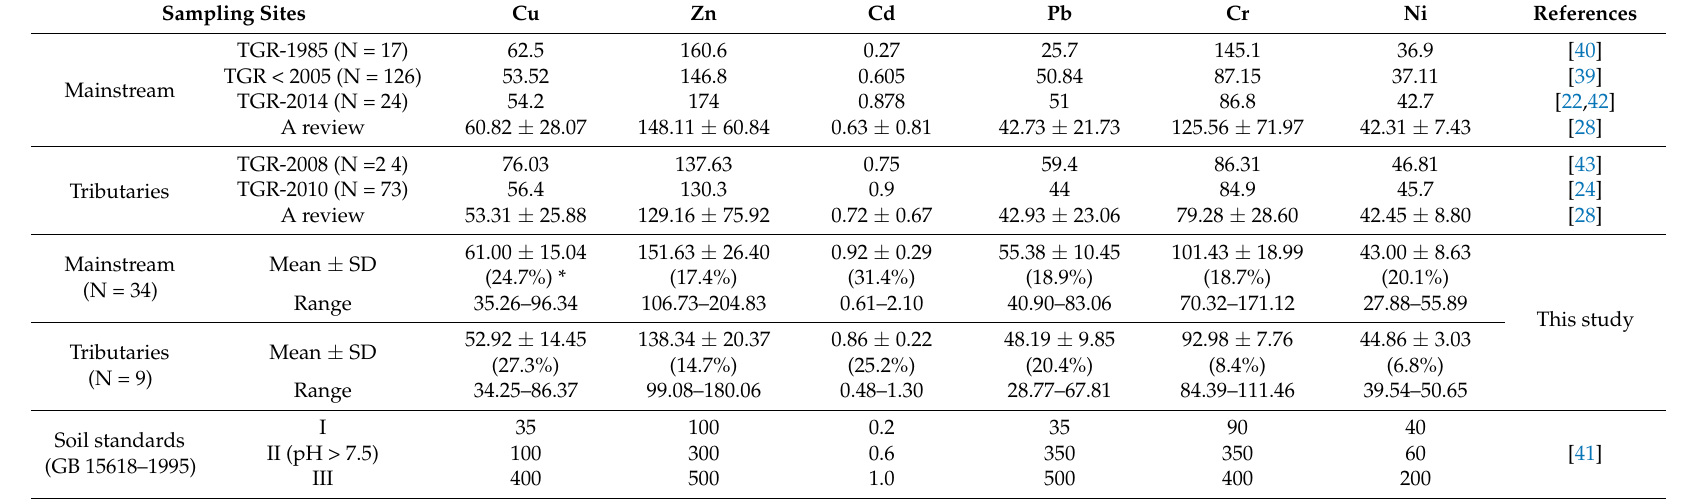
Table 1. Comparison of heavy metal concentrations with previous studies (unit: